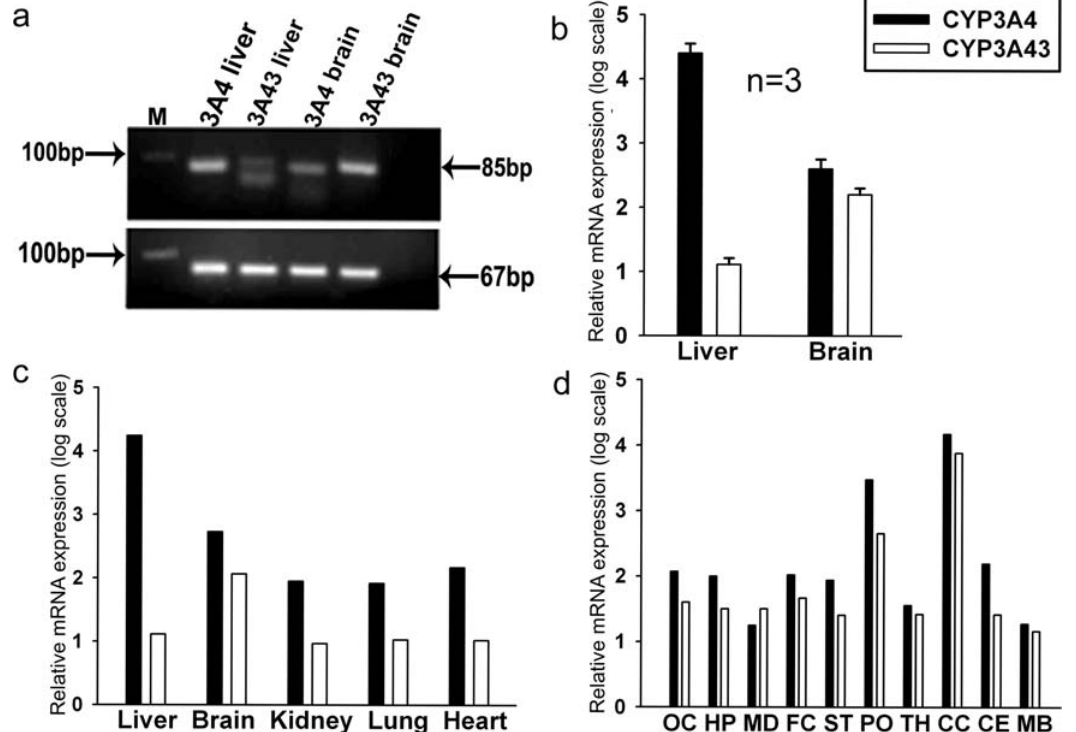
Figure 3. Quantitative assessment of the expression of CYP3A4 and CYP3A43 in human brain cortex. (a) RT-PCR amplification of the 85bp of 3 9 -UTR of CYP3A43 and 78bp of 3 9 -UTR of CYP3A4 using human brain and liver RNA. (b) qRT-PCR analysis using human liver and brain RNA (n=3) showed the relative higher expression of CYP3A43 in brain compared to liver from the same individuals. Quantitation of the relative expression of CYP3A4 and CYP3A43 in (c) different human brain tissues (n=1) and (d) from different regions of the brain from same individual (n=3).